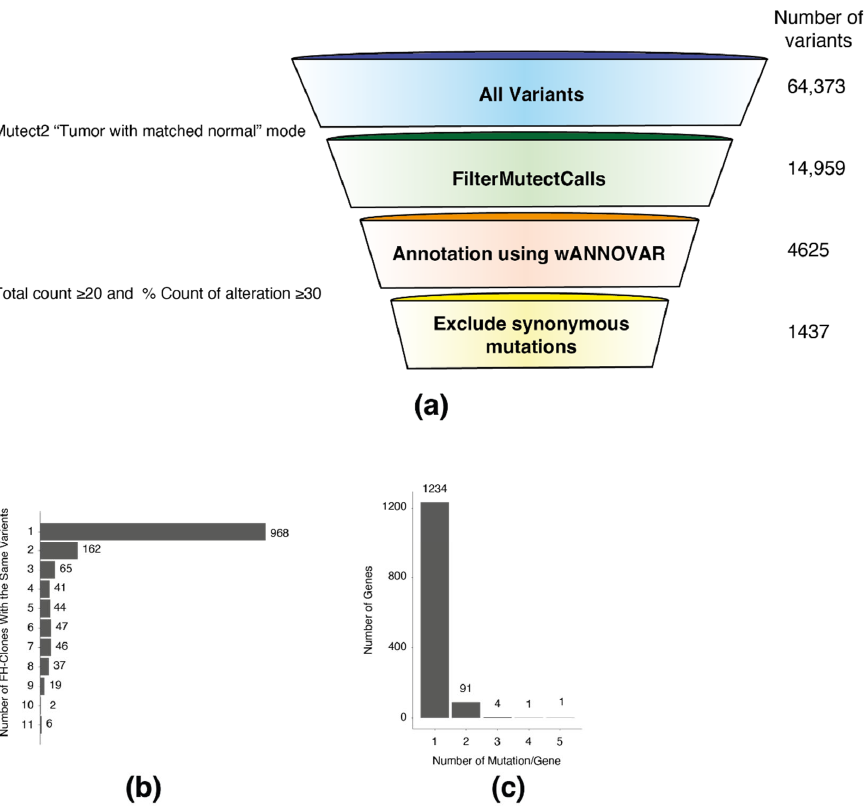
Figure 3. Exome sequencing analysis of FH knockout cells. ( a ) Whole ‐ genome exome sequencing analysis and variant filtering. Variant filtering funnel scheme with the number of variants left after each filtering (right). ( b ) A column bar graph representing the number of FH ‐ clones with the same variants. The number on the right of the bar indicates the number of variants. ( c ) A column bar graph representing the number of mutations in each gene. The number on the top of the bar indicates the number of genes.